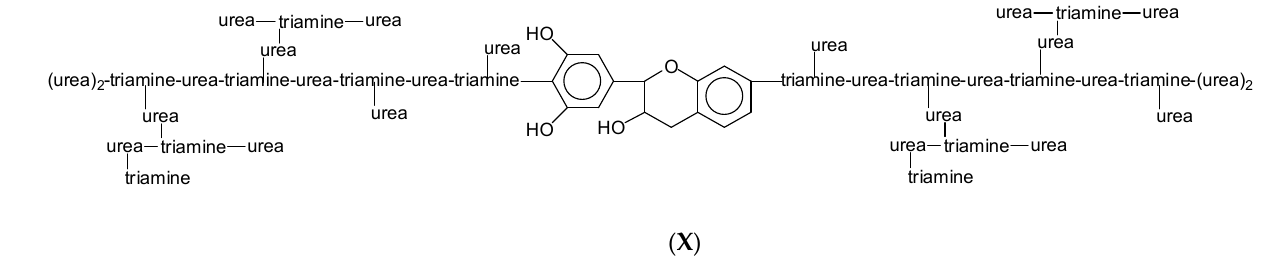
Figure 11. A rare example of a detected structure in which the amide group of a urea has reacted and linked to a flavoid unit of the tannin.